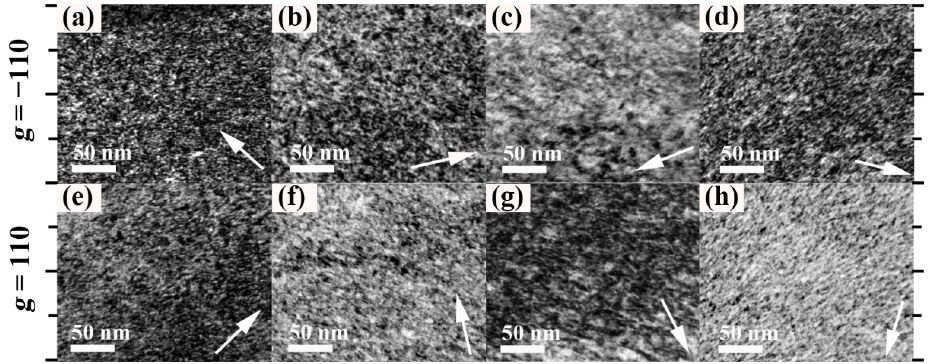
Figure 3. Bright field images of ( a , e ) S0, ( b , f ) S1, ( c , g ) S2, and ( d , h ) S3 at the same position in the depth range of 400–600 nm under g = <110> conditions near the pole [001]. (The white arrow indicates the direction of the g diffraction.) Table 1. Average size and number density of dislocation loops using g = <110> near the pole [001] and hardness increment values of the nano-indentation experiment results.